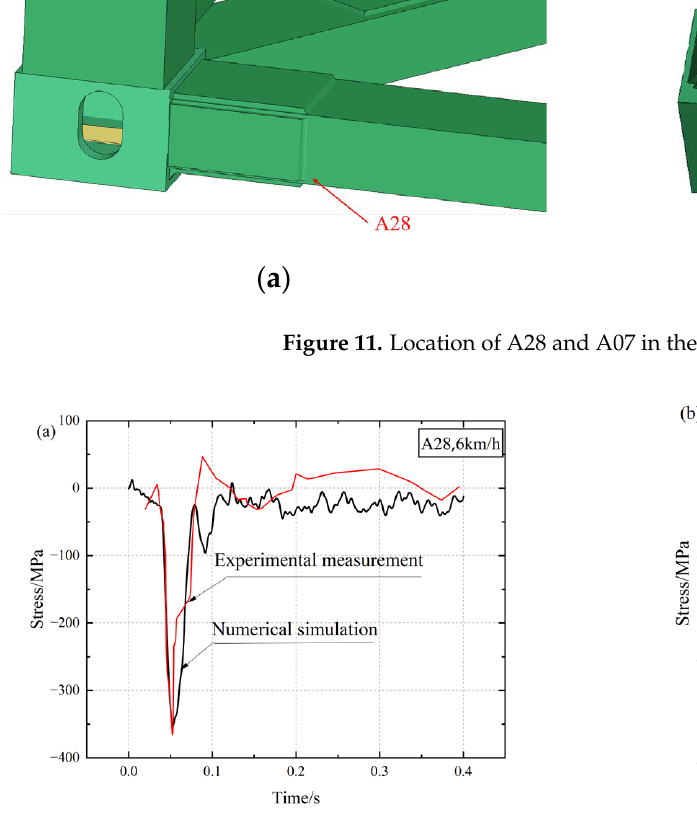
Figure 12. Comparison between experimental and simulated values: ( a ) A28 with the impact vehicle velocity of 6 km/h; ( b ) A07 with the impact vehicle velocity of 8 km/h.